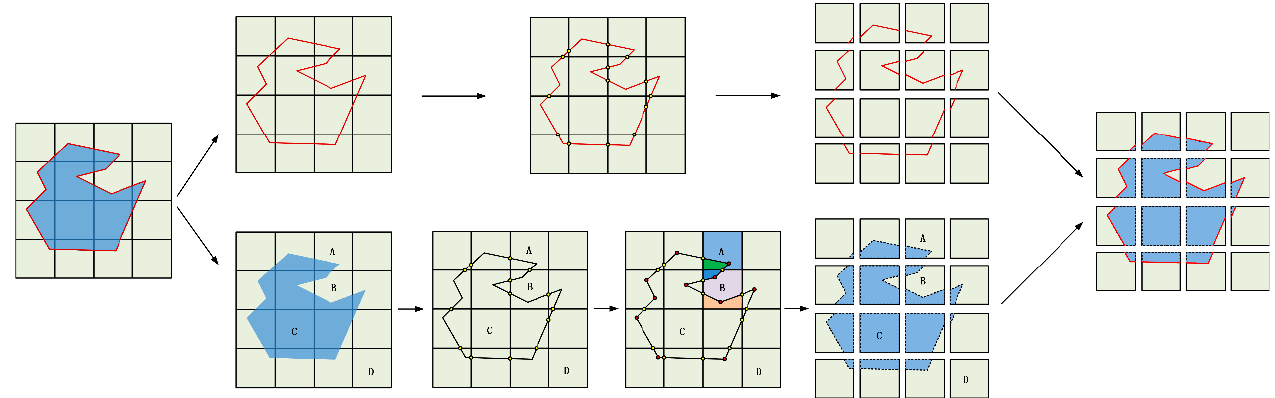
Figure 4. Segmentation of